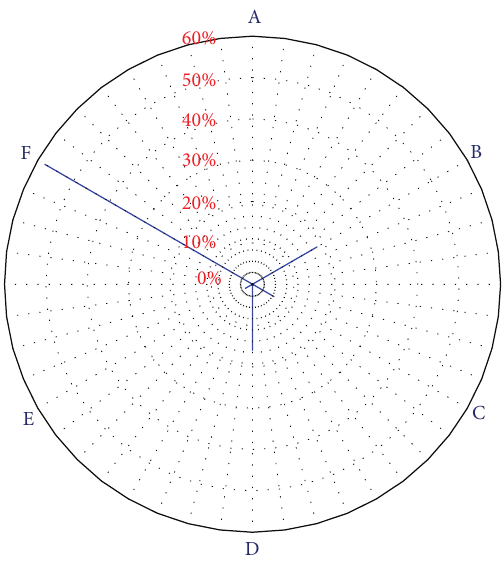
Figure 3: Dominant stability